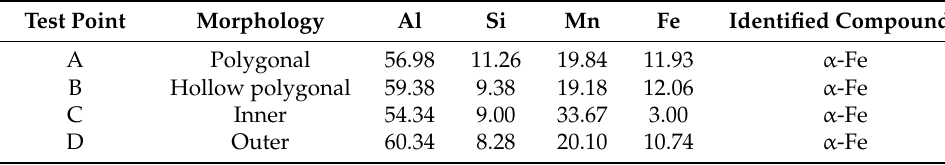
Table 4. Chemical composition of Fe-rich phase in slag